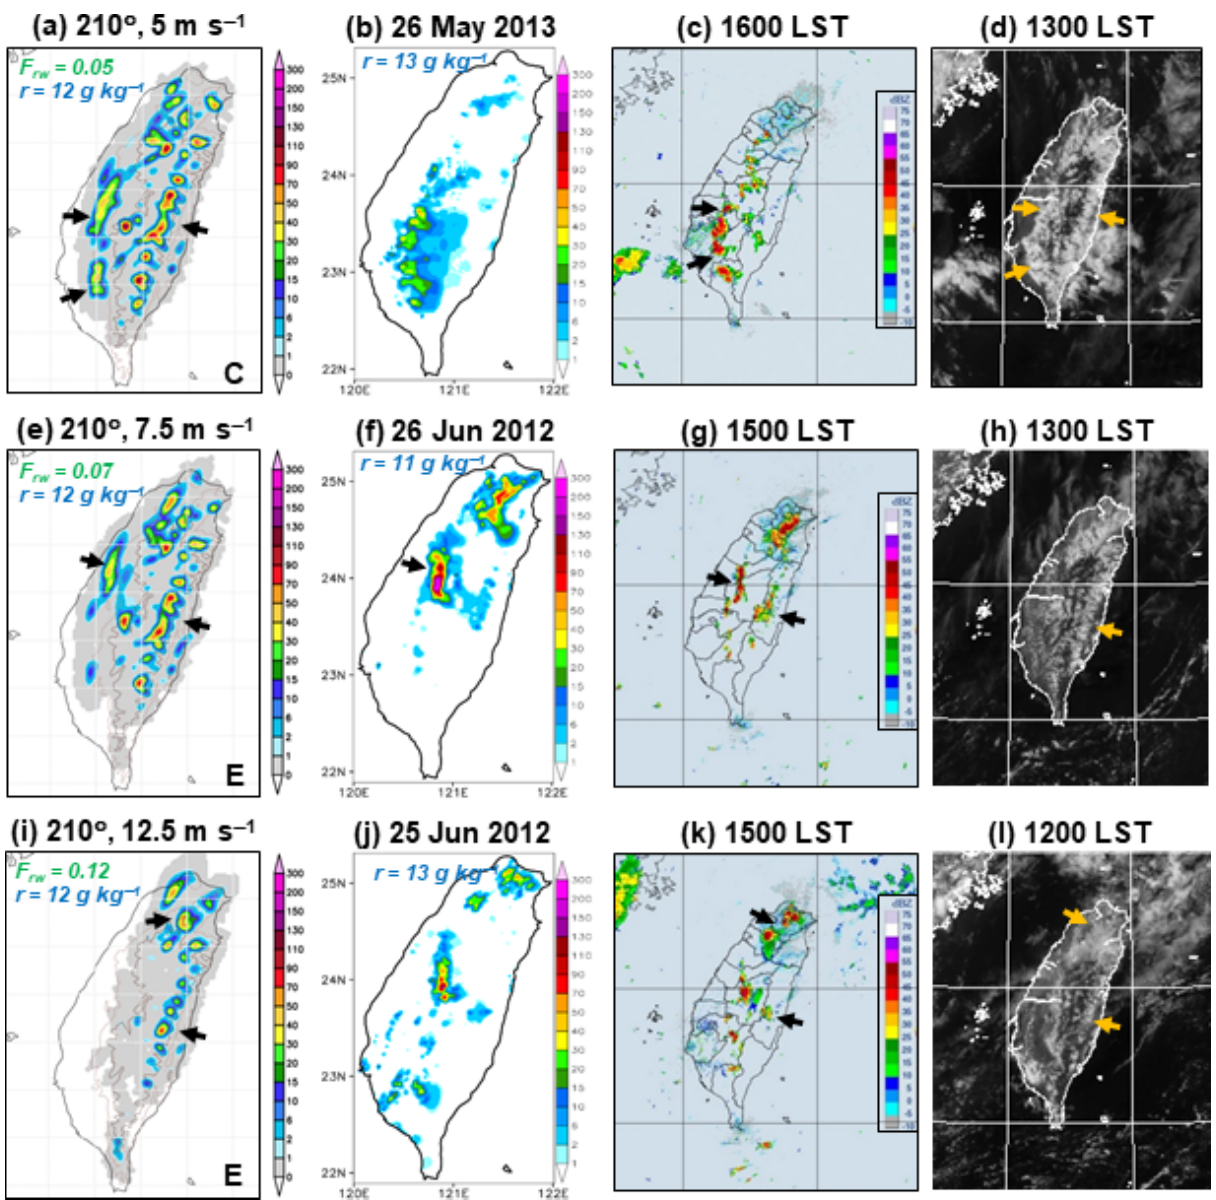
Figure 11. Comparison between results of idealized daily rainfall distributions (mm) in this study (first column) and real events on specific dates under observation, including QPESUMS (mm, second column) and radar composite (dBZ, third column) and visible cloud imagery from MTSAT-2 (fourth column) at the selected time on the same day (as labeled) for the flow direction of 210 ◦ in the low- Fr w regime. The three idealized wind speeds include (a) 5ms − 1 , (e) 7.5ms − 1 , and (i) 12.5ms − 1 , and the corresponding dates under observation are (b–d) 26 May 2013, (f–h) 26 June 2012, and (j–l) 25 June 2012, respectively. The values of Fr w and near-surface mixing ratio (gkg − 1 , top left), as well as the subregion of peak daily rainfall (N, C, S, or E; lower right), in the idealized results are also labeled. The arrows mark features of interest (see text). All observations are from the CWB, and the QPESUMS are also from the National Science and Technology Center for Disaster Reduction